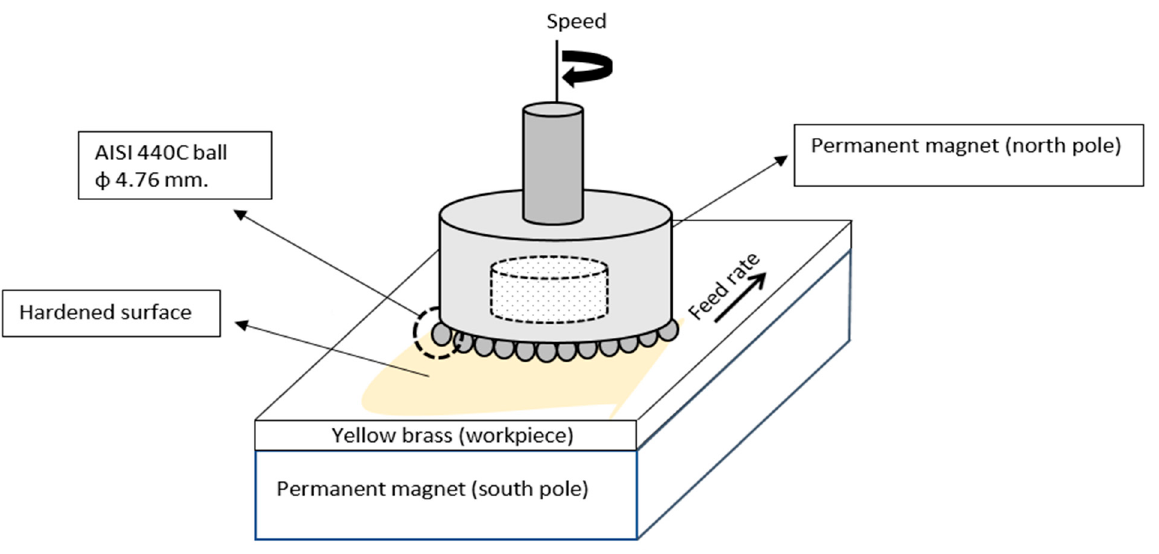
Figure 1. Magnetic surface work hardening process performed in this work.